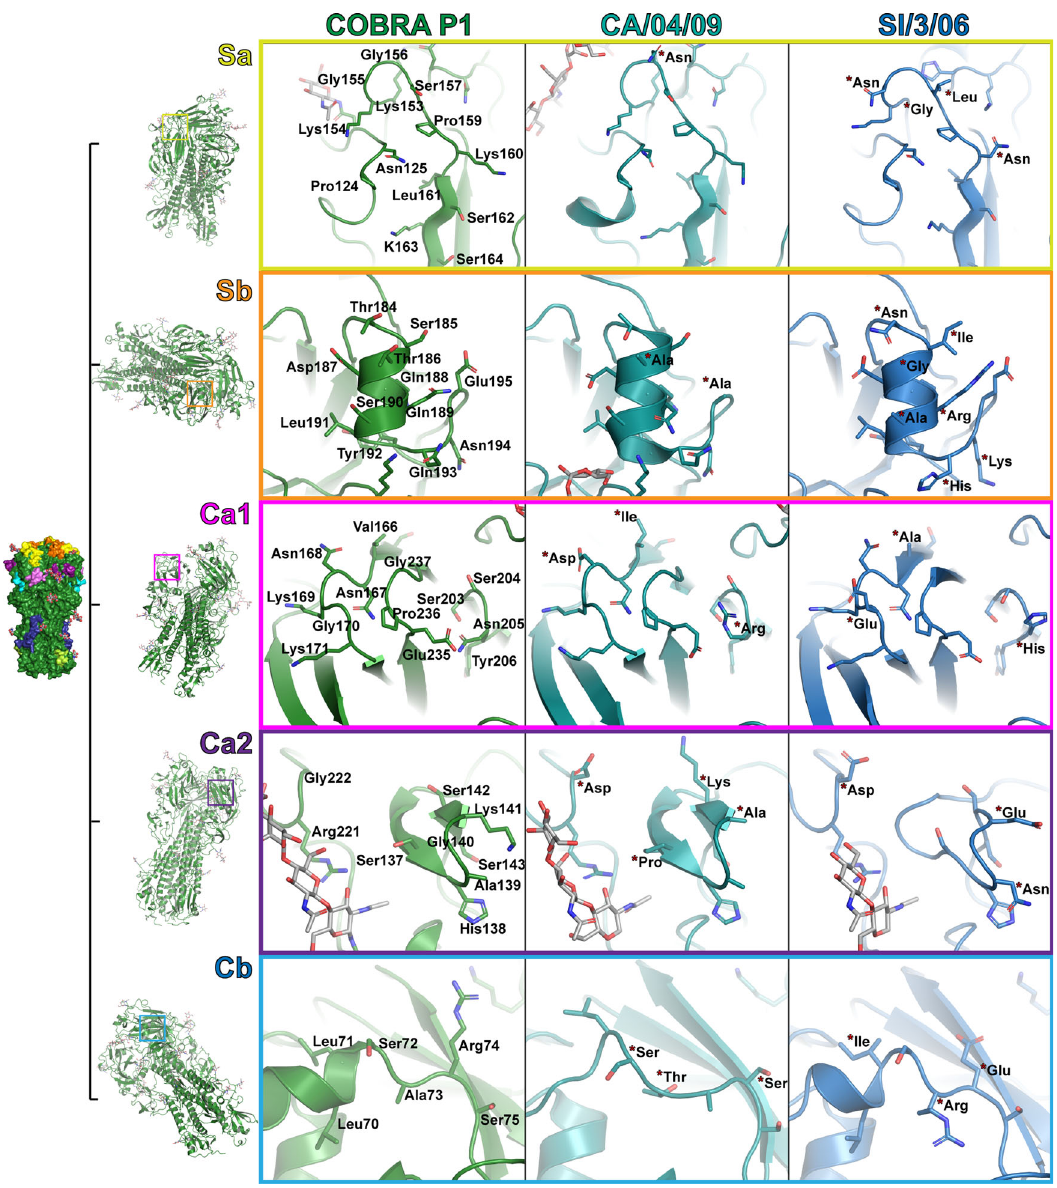
Fig. 3 Structural features of HA head antigenic sites. Crystal structures of HA from CA/04/09 and SI/3/06 (PDB entries 3LZG and 6CF7) were aligned to COBRA P1. The residues forming the major head antigenic sites Sa, Sb, Ca1, Ca2, and Cb are shown as sticks. Residue names and numbering are shown for COBRA P1, with those that differ in CA/04/09 and SI/3/06 indicated by red asterisks with differing amino acid